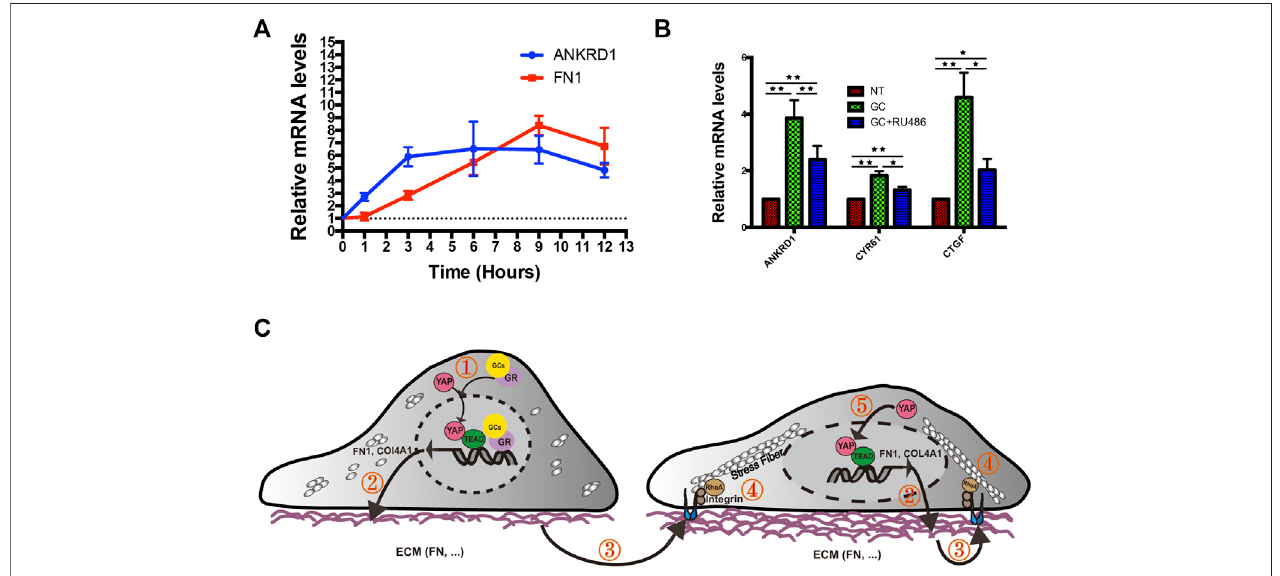
FIGURE7| Proposedworkingmodelsummarizingtheresultsfromourstudy. (A) :Real-time qPCRanalysisofHRCECstreatedwith0.8 μ Mhydrocortisoneforthe indicated times. The mRNA levels of FN1 and ANKRD1 (targets of YAP) were calculated. The experiment was biologically repeated three times. (B) : Real-time qPCR analysis of HRCECs treated with 0.8 μ M hydrocortisone alone or in combination with 10 μ M RU486 for 72 h. The mRNA levels of ANKRD1/CYR61/CTGF (targets of YAP) were calculated. The experiment was biologically repeated four times. (C): Schematic diagram showing the transcriptional positive feedback loop that regulatesECMcomponentexpressioninGC-treatedHRCECs.GCpromotesYAPnuclearlocalizationtoinduceECMcomponent(FNandColIV)expression( ① and ② ). TheincreaseinFNactsonintegrintopromotestress fi berformation( ③ and ④ ),whichappliesforcestothenucleusand fl attensit.Thischangeinturnleadstoincreased YAP import through the stretched nuclear pores ( ⑤ ). The error bars represent the mean ± SD. *P < 0.05, **P < 0.01. Student ’ s two-tailed paired t -test (B) . ECM extracellular matrix, FN fi bronectin.